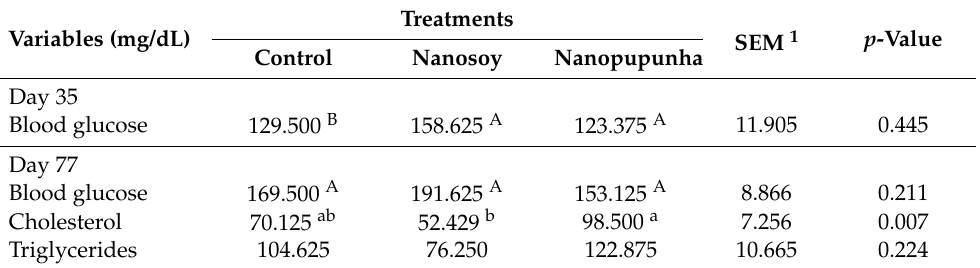
Table 6. Plasma glucose levels in rabbits at the beginning of the experiment (age = 35 days) and the glucose, cholesterol, and triglyceride (mg/dL) levels at the end of the experiment (age = 77 days). Variables (mg/dL)